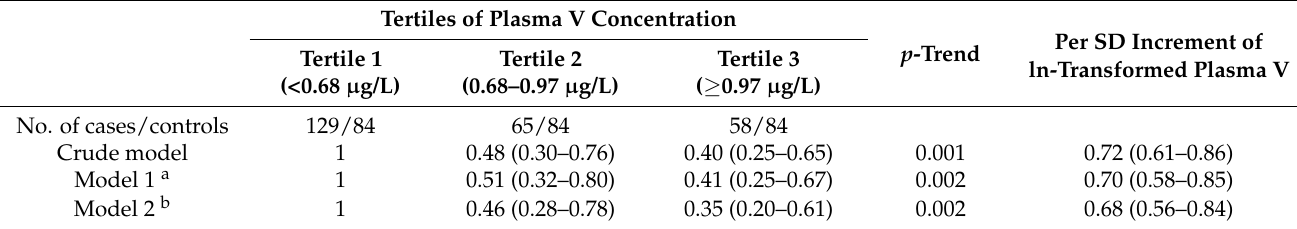
Table 2. Association of plasma V concentrations with GDM.